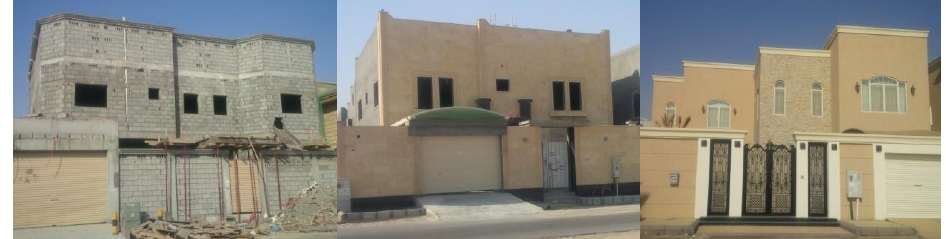
Figure 5. Sample modern houses in Saudi Arabia.